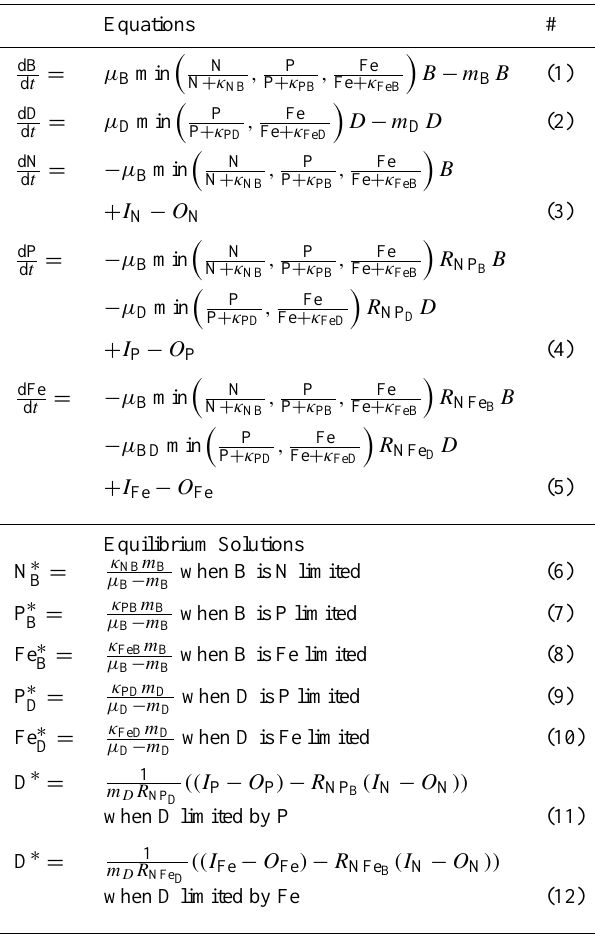
Table 5. Theoretical provinces. These descriptions of the provinces come from the framework outlined in Table 4. No entry means there is no theoretical